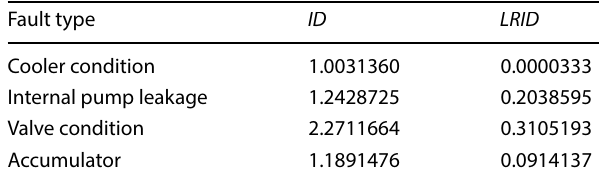
Table 3 Degree of class imbalance